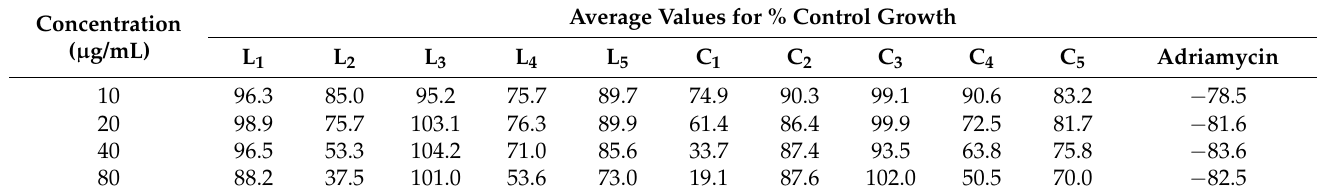
Table 9. Average values for % control growth for the cell line MCF-7.